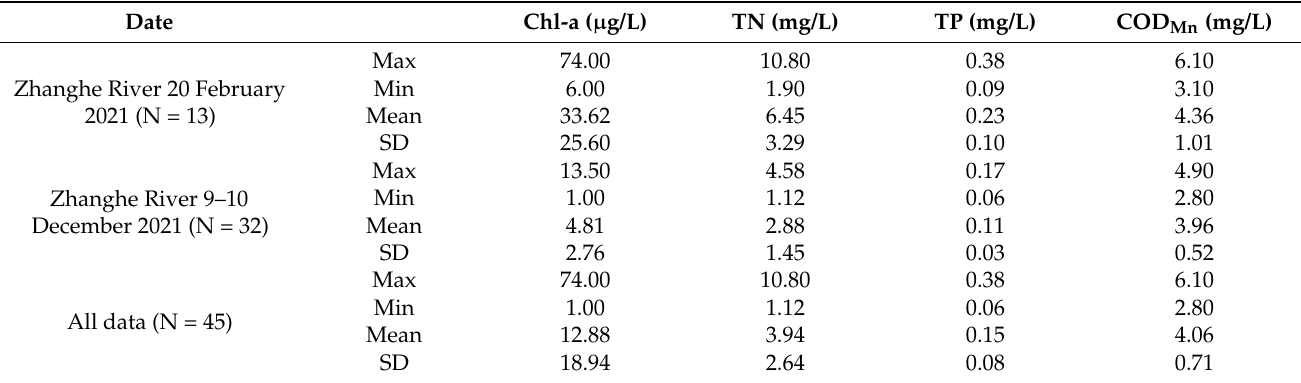
Table 4. Analysis of measured water quality data of the two sampling periods. SD represents the standard deviation, and N represents the number of sampling points. Units are µ g L − 1 for Chl-a, and mg L − 1 for TN, TP, and COD Mn